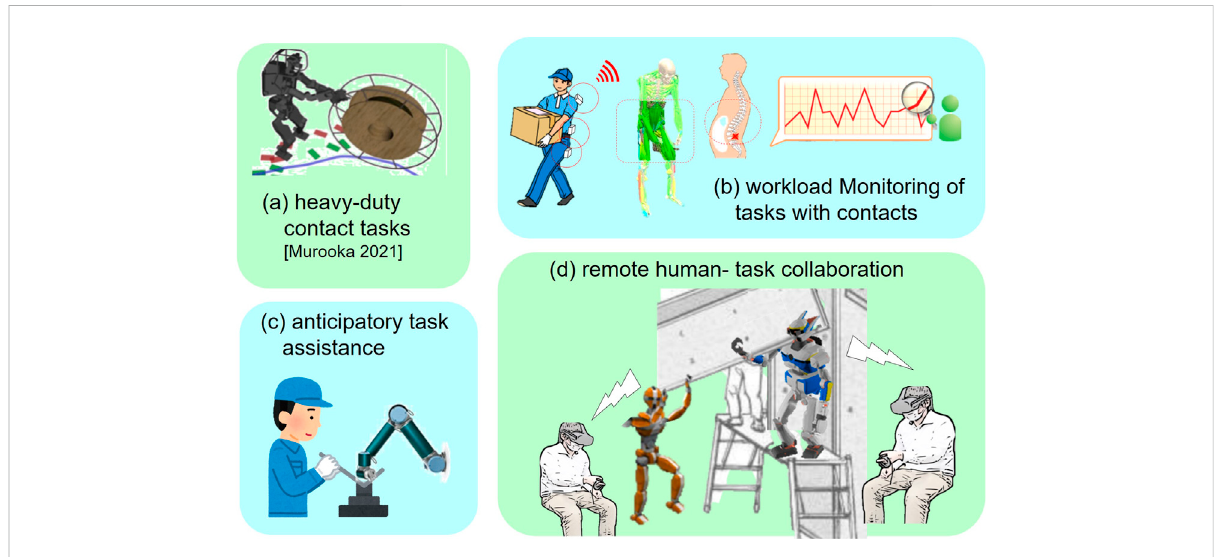
FIGURE 7 Possible applications of the proposed data-driven contact motion synthesis for humans and humanoid